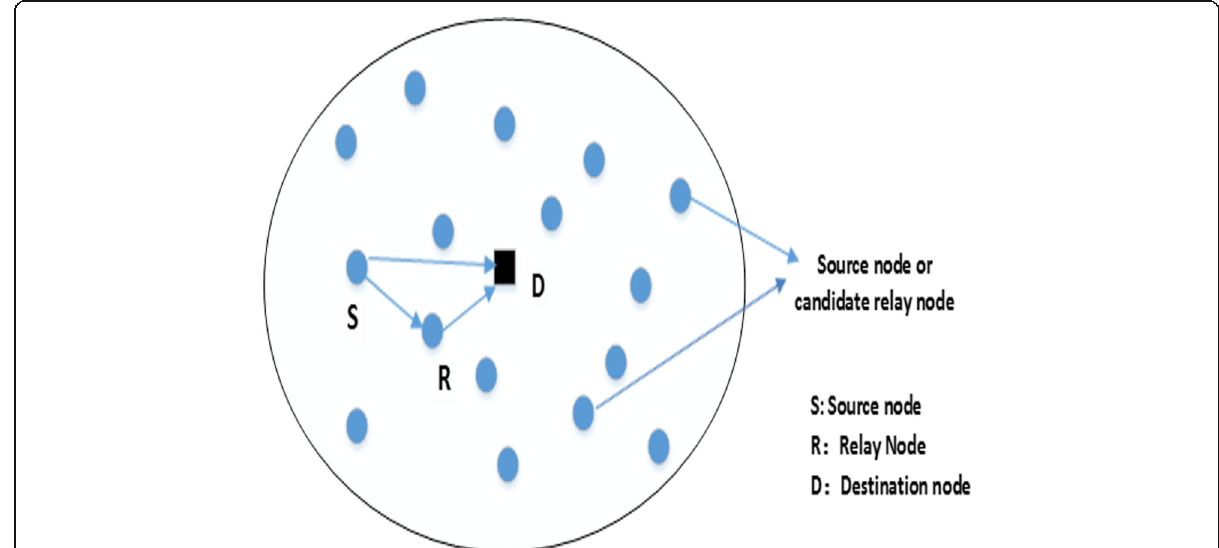
Fig. 1 System model of collaborative relay